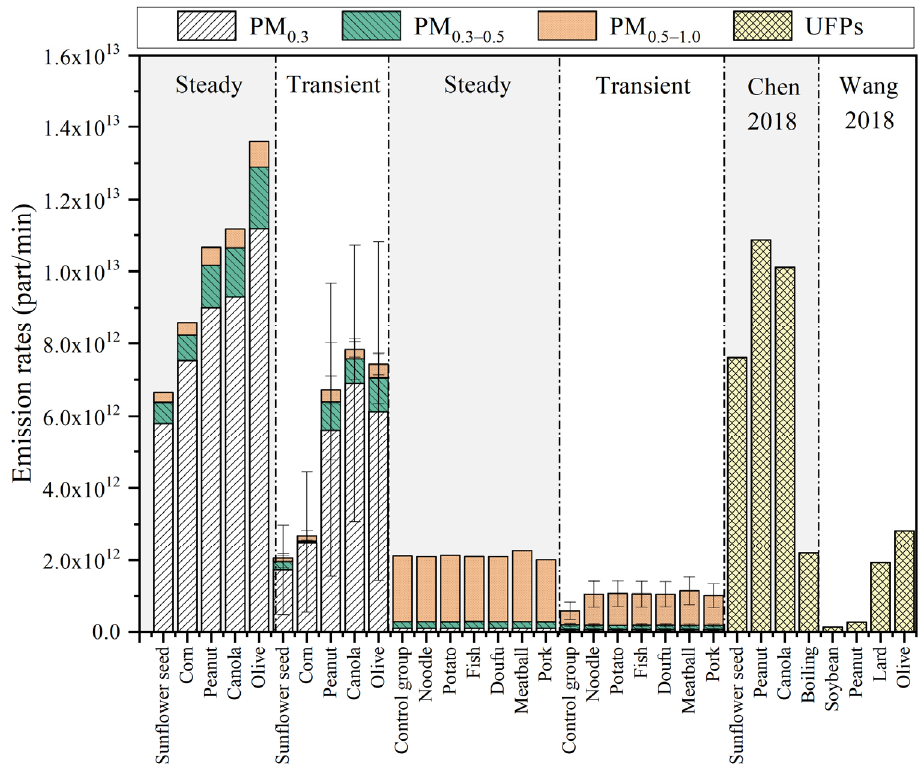
Figure 8. Comparison of emission rates with previous